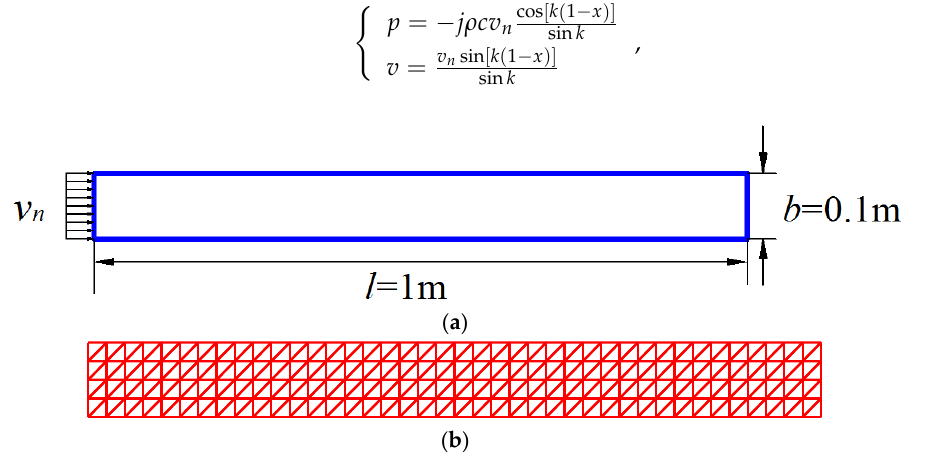
Figure 4. The acoustic propagation in a two-dimensional tube: ( a ) the geometry parameters of this tube and ( b ) the employed spatial discretization pa tt ern.